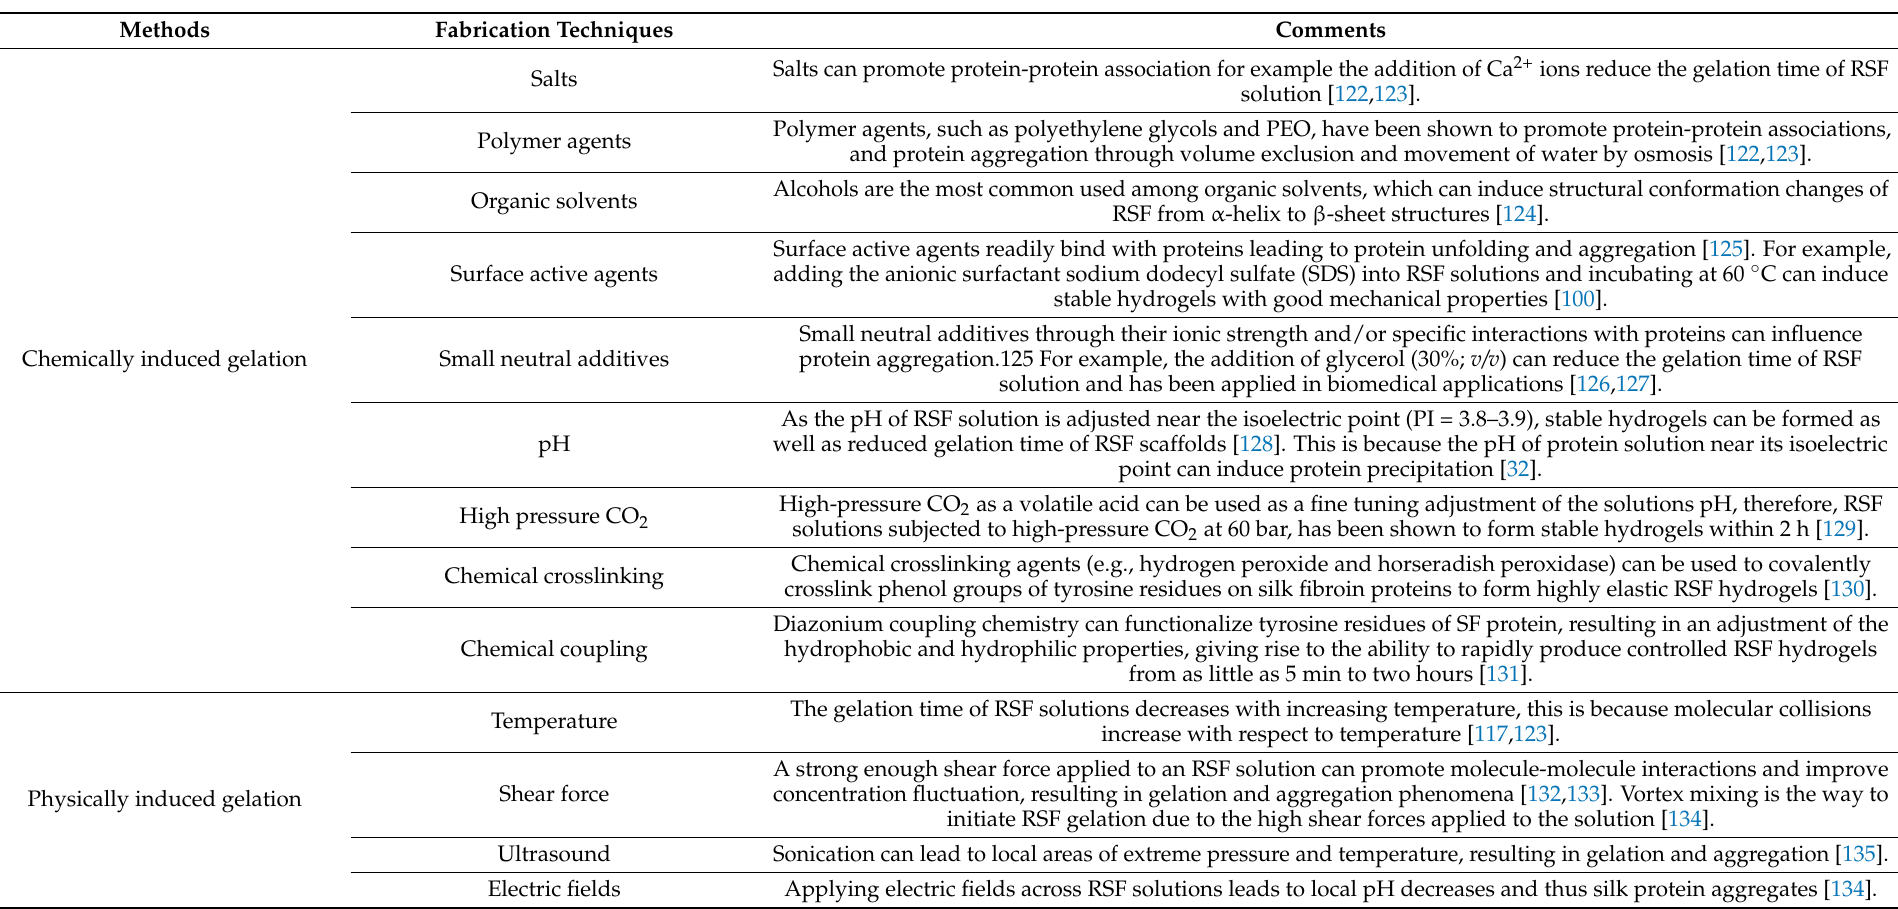
Table 1. Key silk fibroin hydrogel fabrication